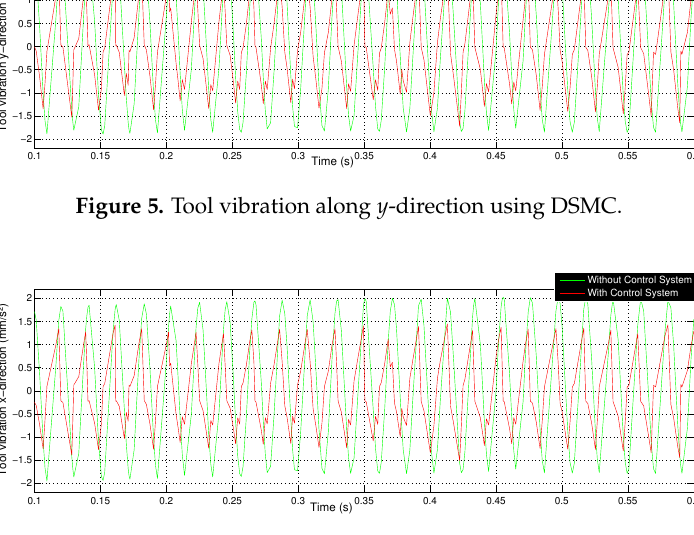
Figure 6. Tool vibration along x -direction using D-PID.